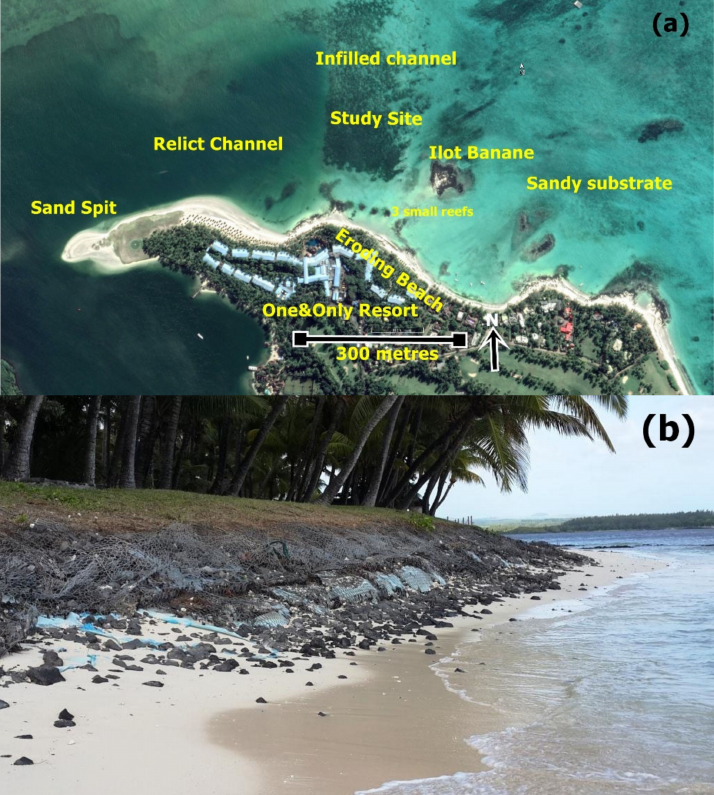
Figure 2. ( a ) The St Geran shoreline and geomorphic features prior to reef construction. The primary study site is the “Eroding Beach” in the lee of Ilot Banane. ( b ) Eroded beach and exposed gabion baskets after cyclone Berguitta in January 2015.